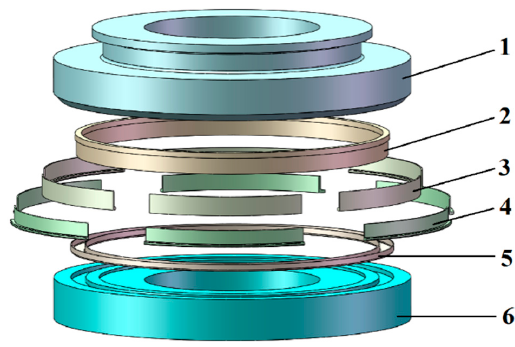
Figure 3. Exploded view of concave ring stamping die assembly. 1—upper; 2—middle inner; 3—internal inner; 4—external inner; 5—blank;